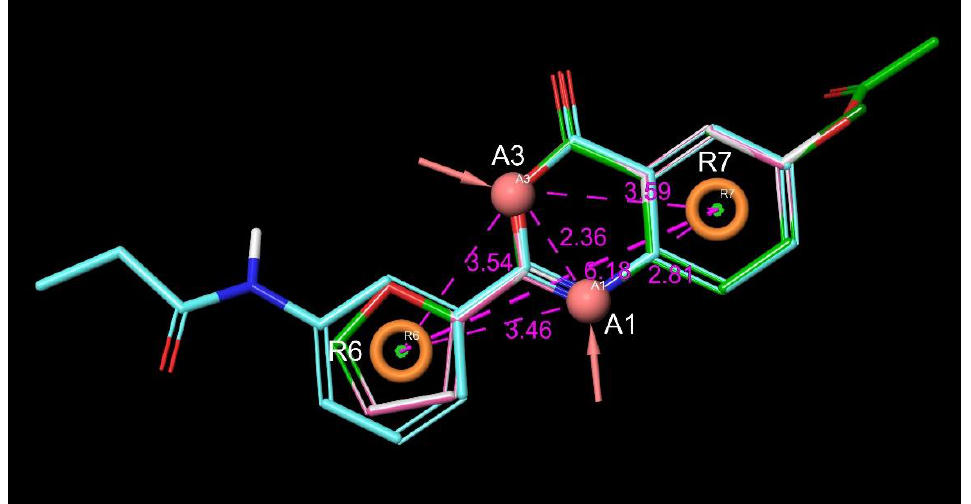
Figure 4. The selected 3,1-benzoxazin-4-one model (AARR_3). Unlike the other two models, this